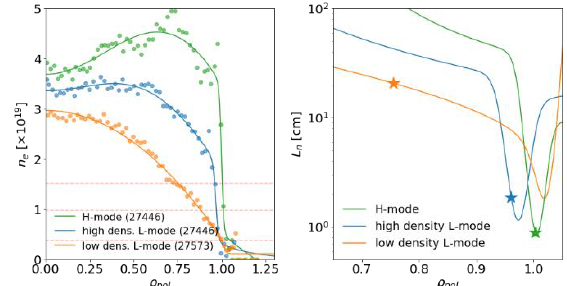
Fig. 11 : Left: density profiles for H-mode, high-density L- mode and low-density L-mode. Dashed lines indicate cut-off densities for 17.25, 28 and 34.8 GHz. Right: density scale lengths for these profiles. Stars represent scale lengths at 34.8 GHz in each